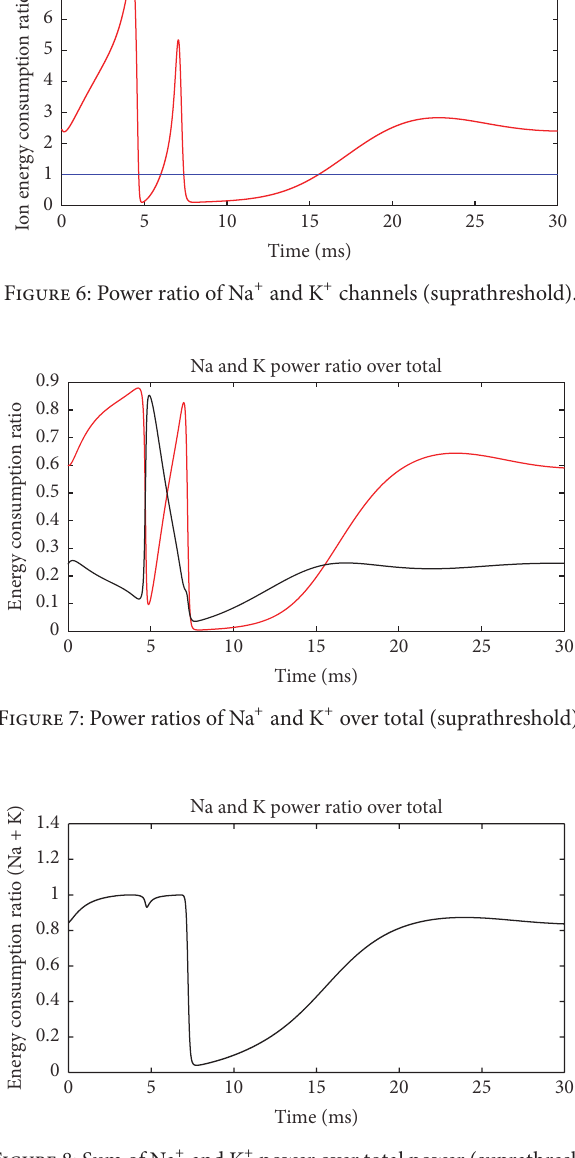
Figure 8: Sum of Na + and K + power over total power (suprathresh-